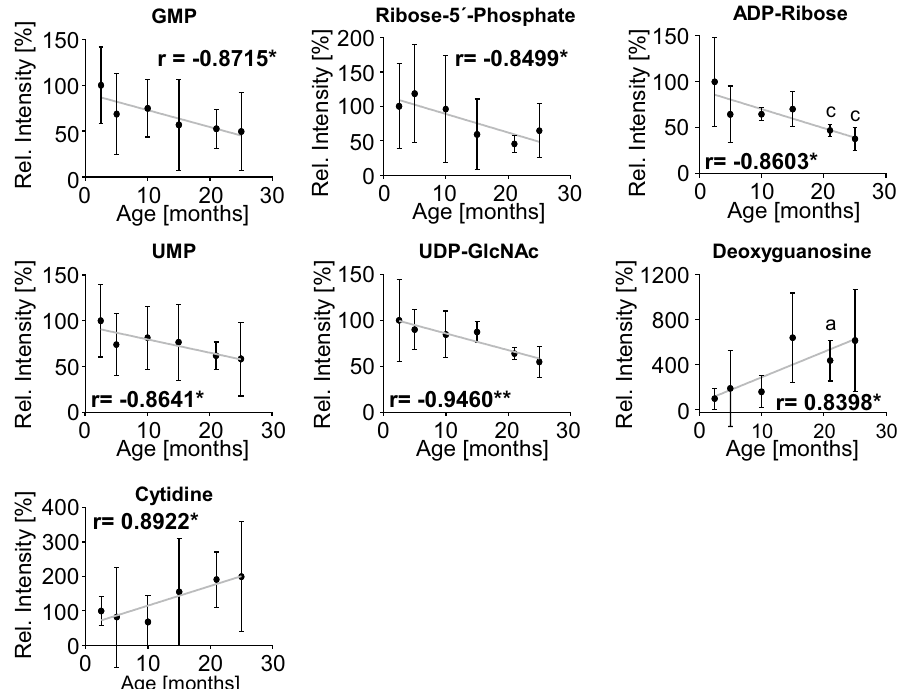
Figure 4. Polar metabolites involved in nucleotide metabolism correlate with BAT aging. Spearman correlations of individual polar metabolites linked to nucleotide metabolism that are significantly associated with aging (from left to right, top to bottom): Guanosine monophosphate (GMP), ribose-5´-phosphate, adenosine diphosphate-ribose (ADP-ribose), uridine monophosphate (UMP), uridine diphosphate N-acetylglucosamine (UDP-GlcNAc), deoxyguanosine, and cytidine. Correlation coefficients (r) for individual metabolites were calculated to visualize age-dependent correlations of metabolic species. Individual peak intensities of all age groups were normalized to intensities measured in the 2.5 months control group. All data are depicted as mean ± SD (n = 3 for all groups); * p < 0.05 indicating significant correlation across all age groups; a, b, c, d p < 0.05 comparing relative intensity of the indicated age group compared to (a) 2.5 months, (b) 5 months, (c) 10 months or (d) 15 months, respectively, using two-tailed unpaired